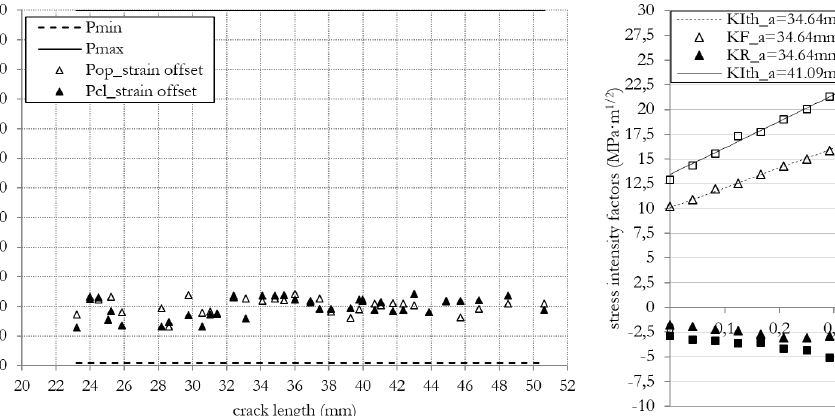
Figure 9: Experimental K F and K R corresponding to the specimen tested at high R -ratio for two different crack lengths (34.64 and 41.09